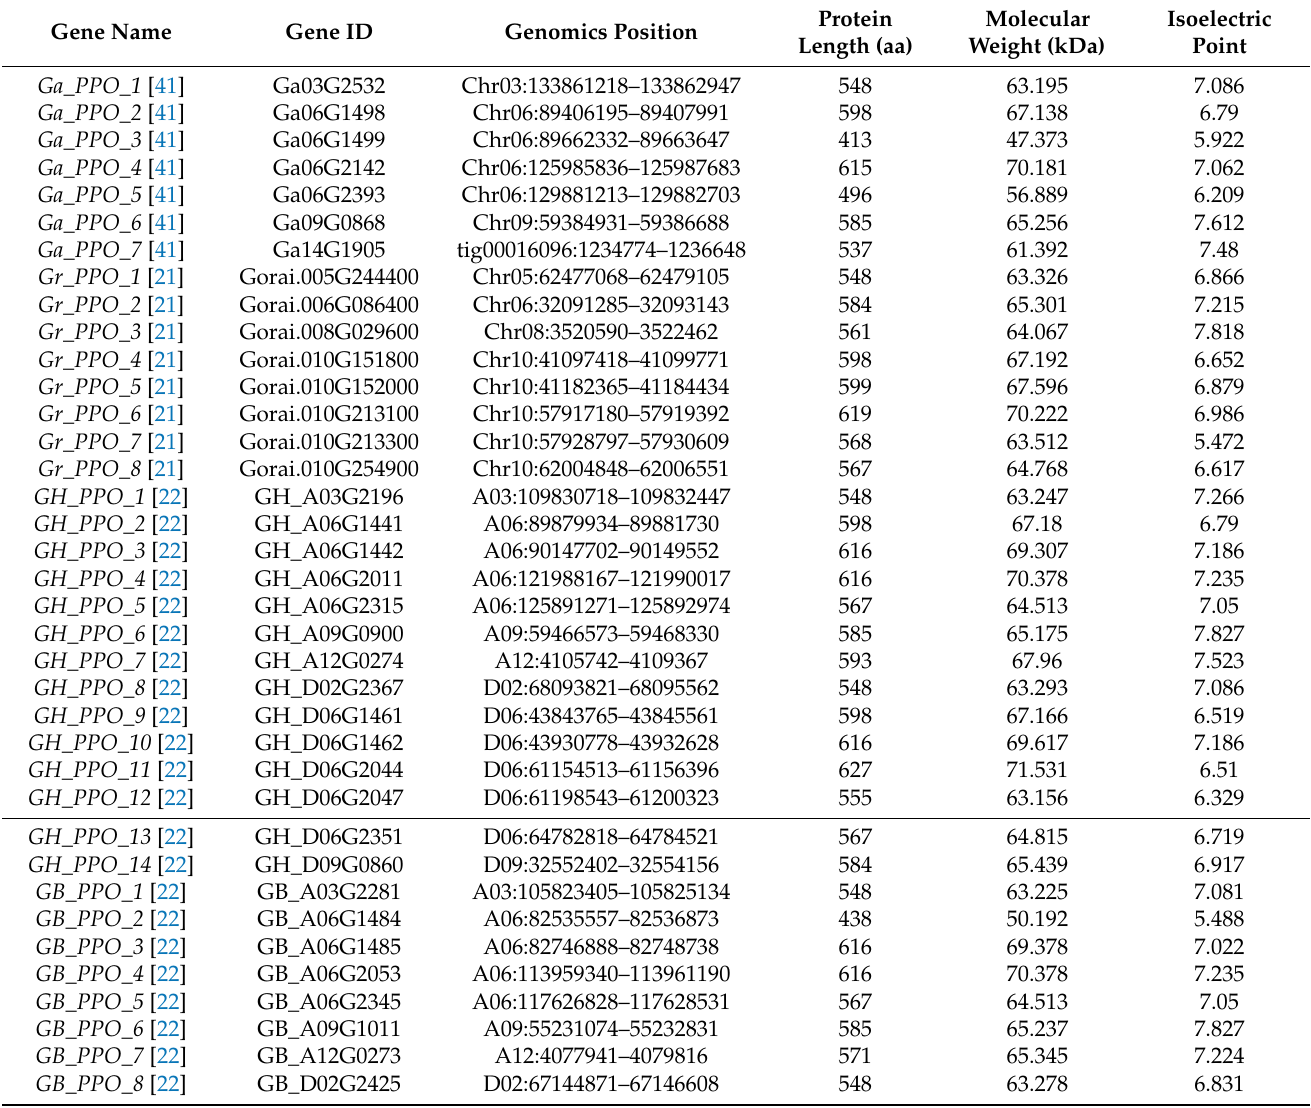
Table 1. Identification and characteristics information of cotton PPO family